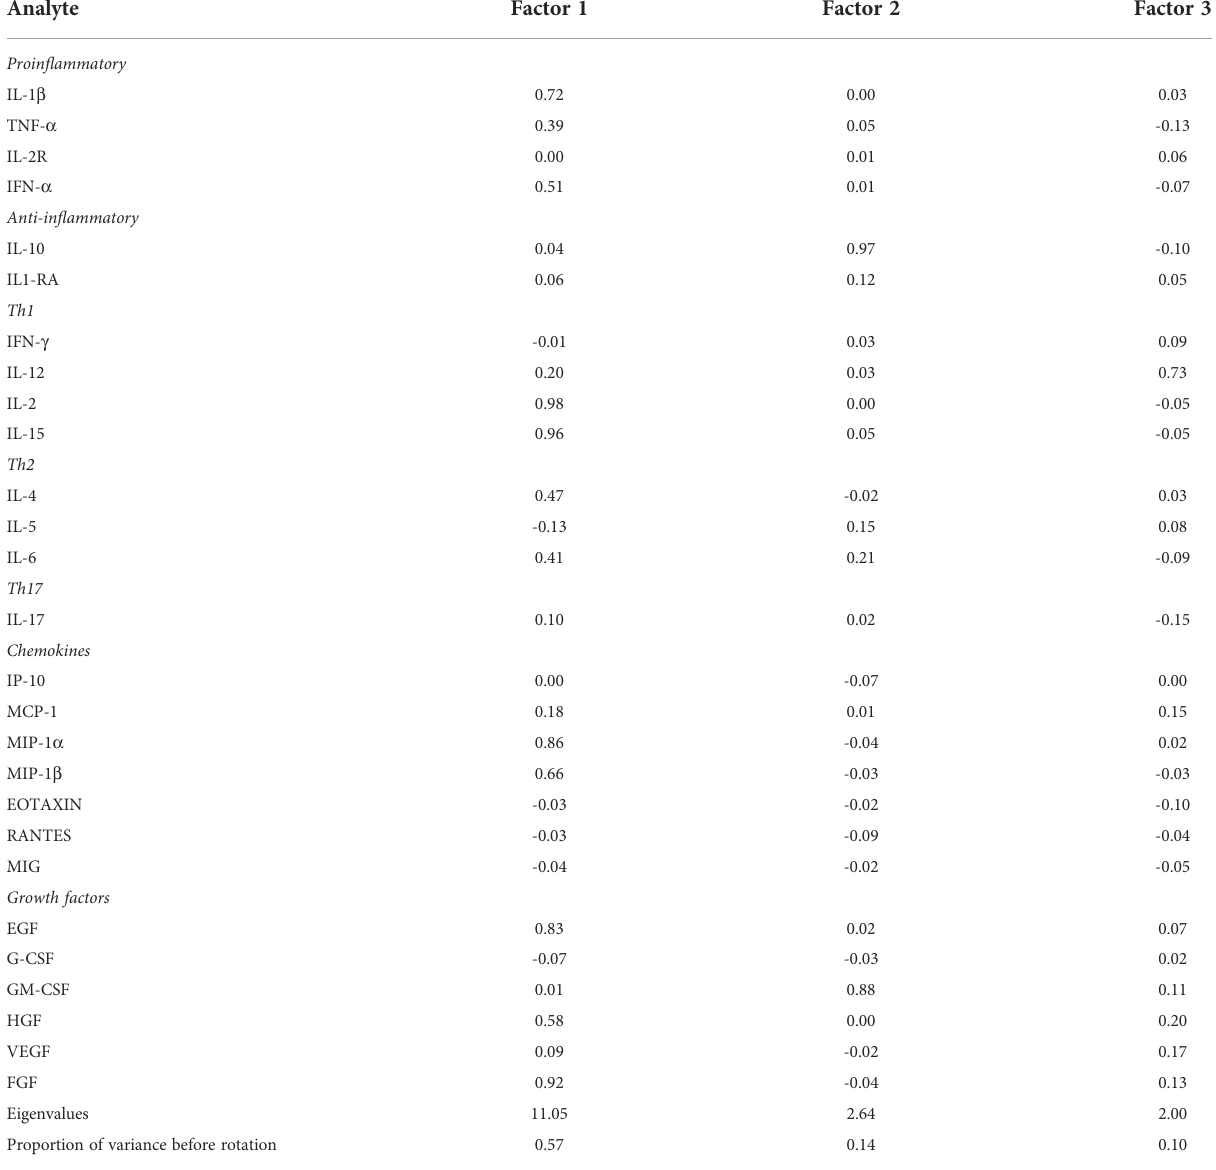
TABLE 3 Rotated factor loading values of the 27 analytes in the 3 main factors elucidated in factor analysis after applying oblique rotation.